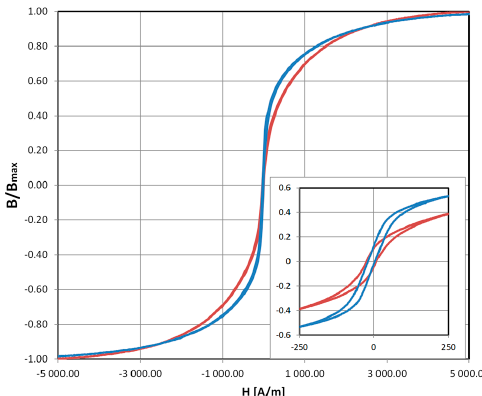
Figure 4. Magnetic B(H) hysteresis loops for the sensor material in as-cast state. Values normalized for saturation induction B max . Red line—hysteresis measured along the ribbon (B X ), blue line—hysteresis measured orthogonally, along the ribbon’s width (B Y ). Slight differences in characteristics are evident, especially in the medium magnetizing field region